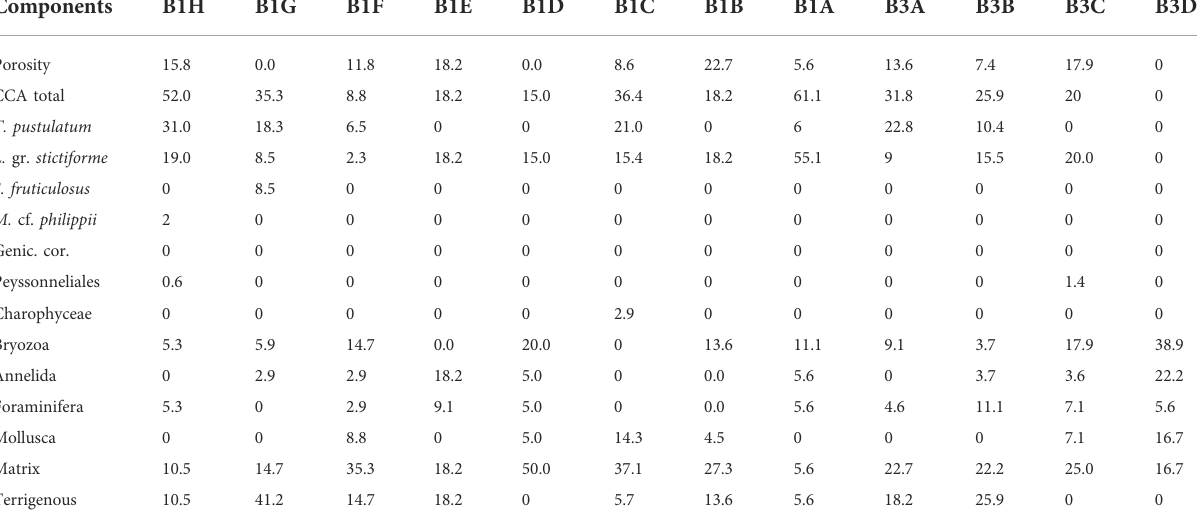
TABLE 5 Point counting results for Bogliasco cores 1 and